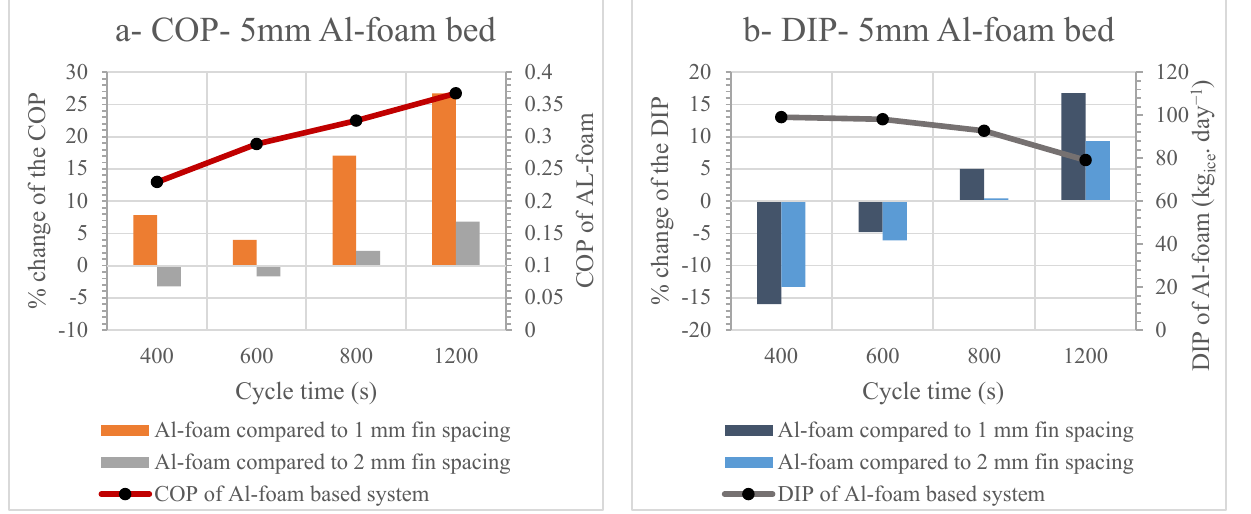
Figure 8. Effect of the cycle time on the percentage change in the system COP and DIP when using Al-foam bed with 5 mm thickness. ( a ) COP, ( b ) DIP.